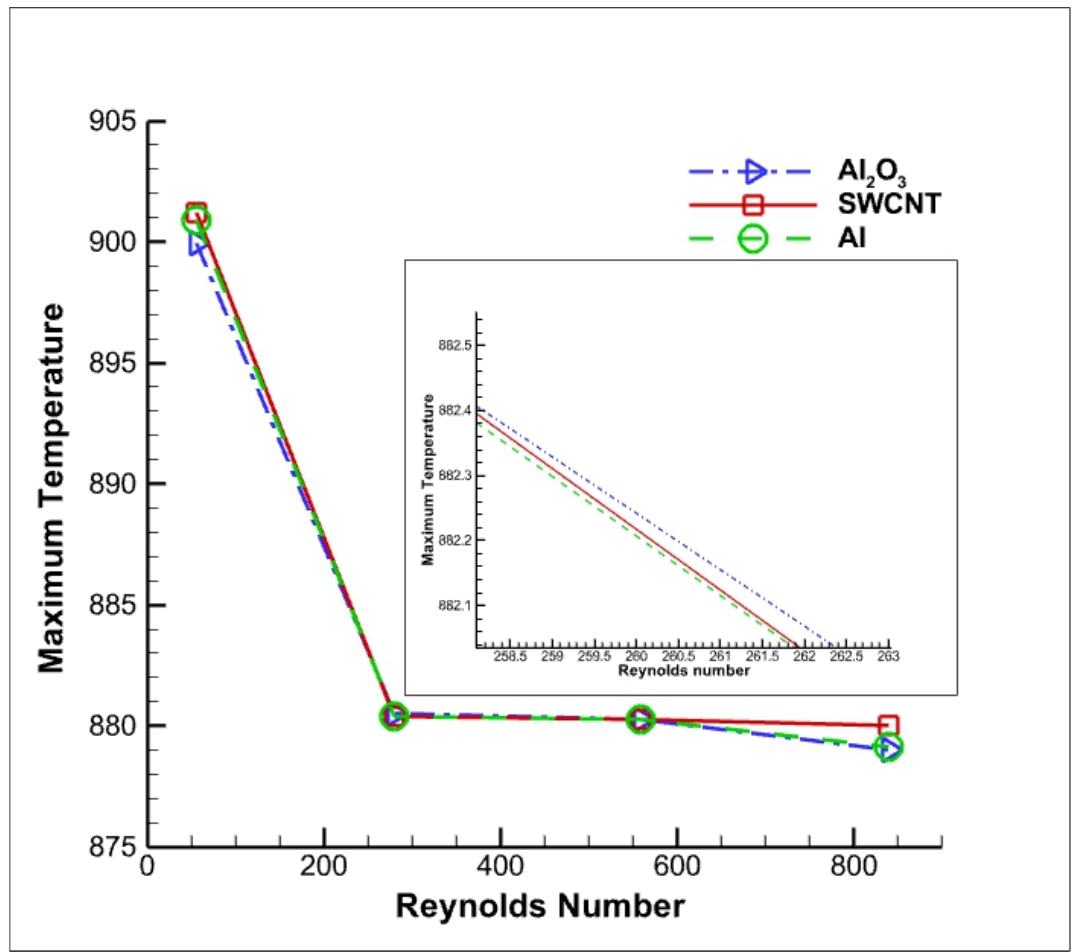
Figure 14. Variation in maximum cutting tool temperature with respect to Reynolds number.